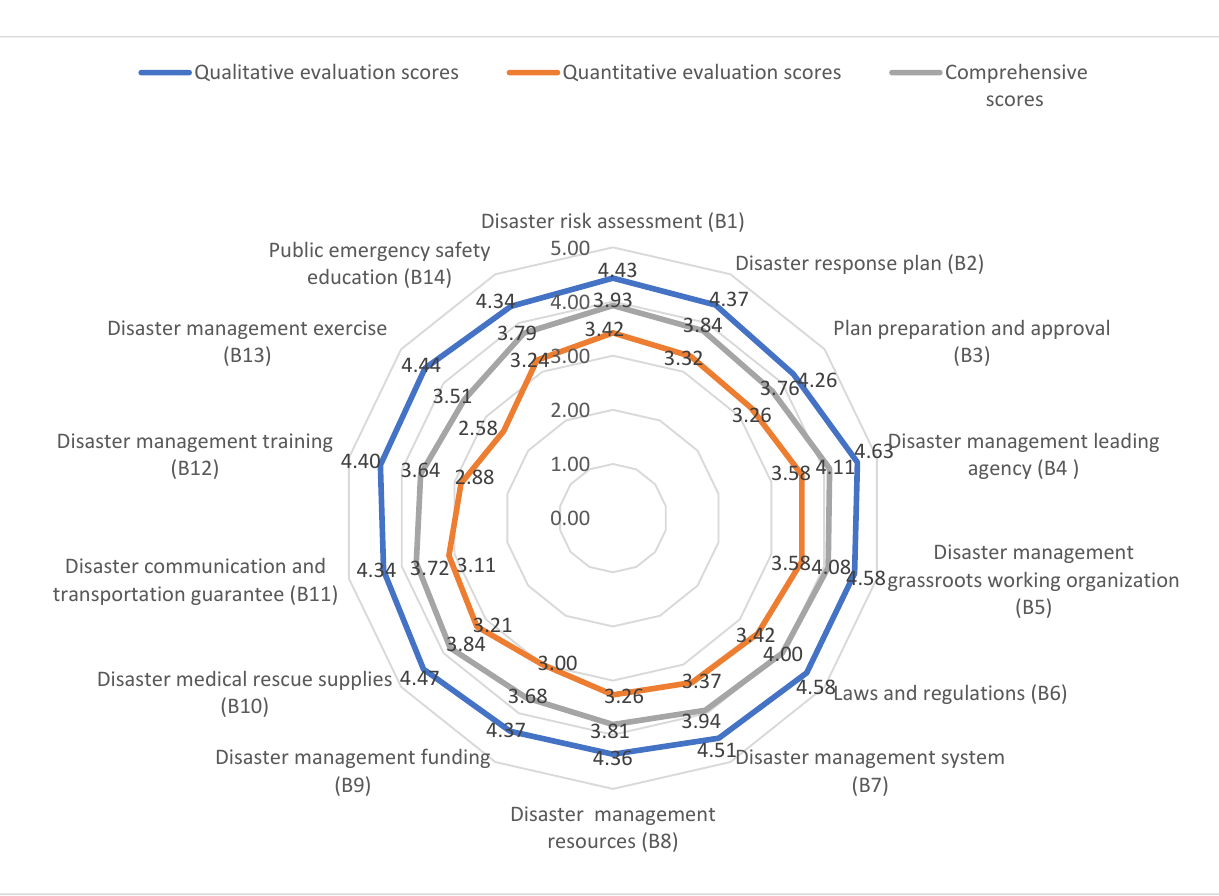
Figure 5. Radar chat of qualitative evaluation scores, quantitative evaluation scores, and comprehensive scores of B1~B14.